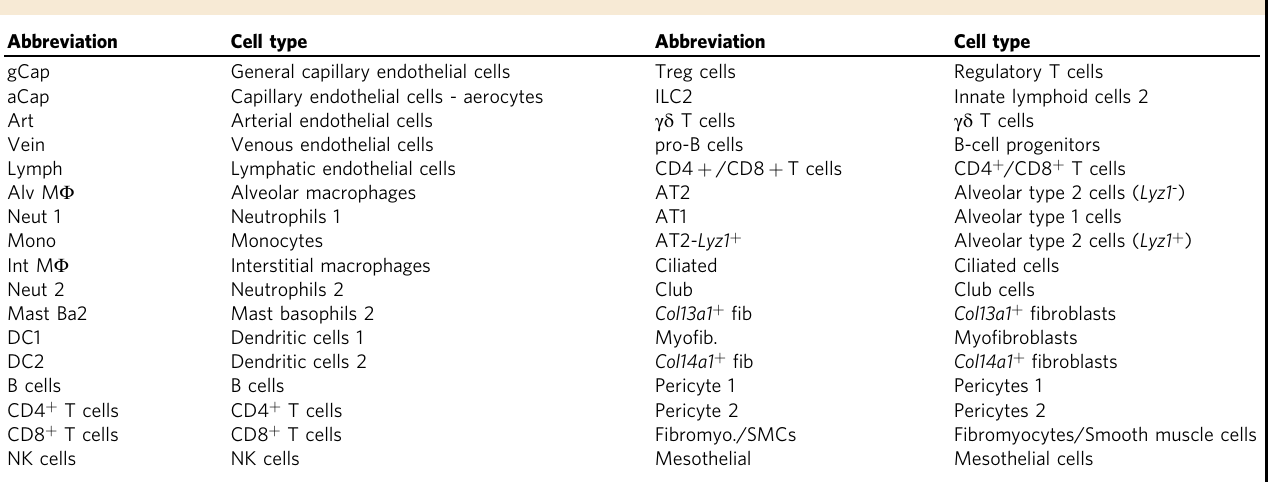
Table 1 Identi fi ed cell